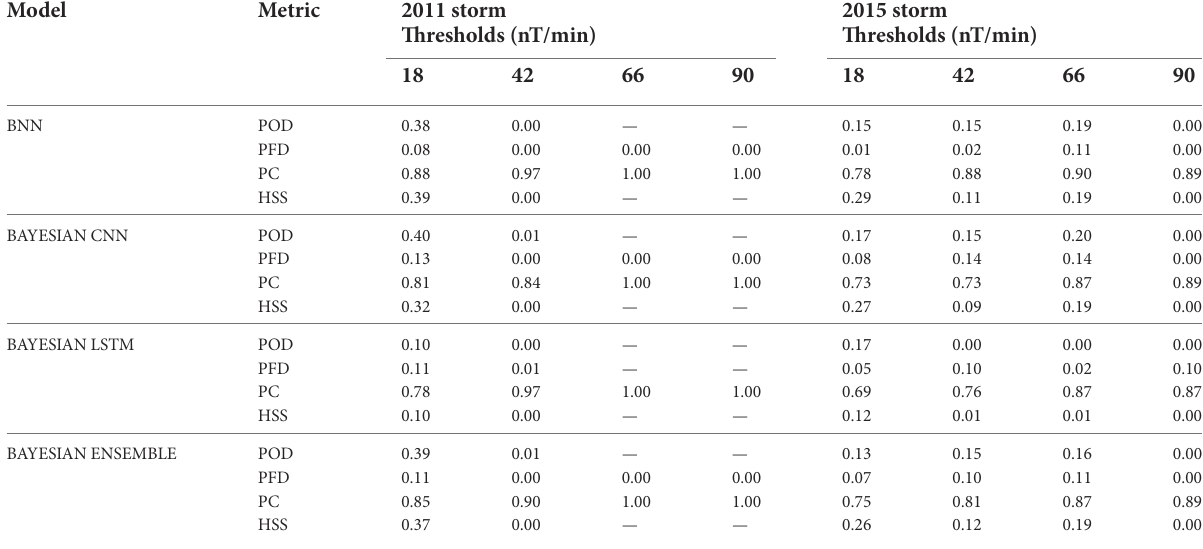
TABLE 2 Validationmetricsforthe05August2011andthe17March2015geomagneticstormsusingpredicted dB H / dt maximumvaluesforevery 20 min timeperiod.Thethresholdvalues(18,42,66,and90)haveaunitofnT/min. Model